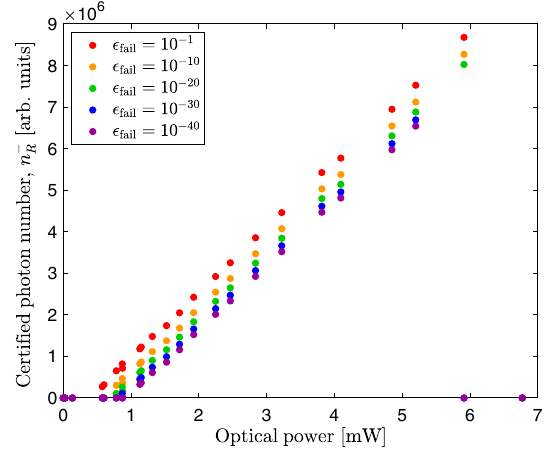
FIG. 3. Certified minimum photon number n − plotted against input optical power for various security param- eters ϵ . Voltage thresholds used in the test P are constrained fail such that all samples pass.